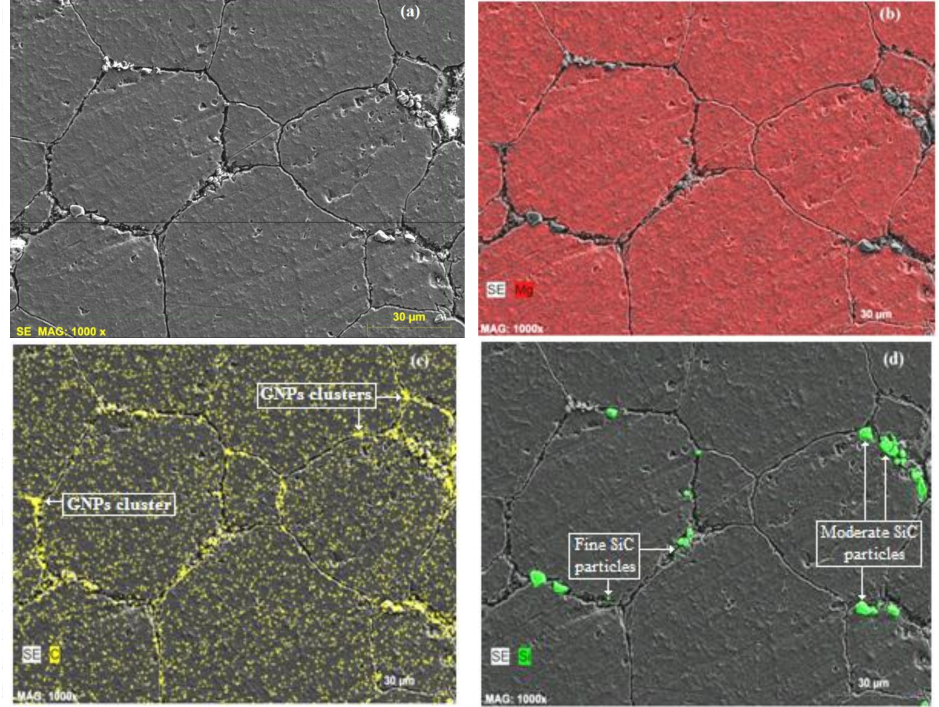
Figure 3. ( a ) SEM surface image of Mg/10 wt %SiC/0.25 wt %GNPs hybrid MMC; ( b ) X-ray mapping of Mg matrix; ( c ) distribution of carbon (GNPs); and ( d ) distribution of SiC